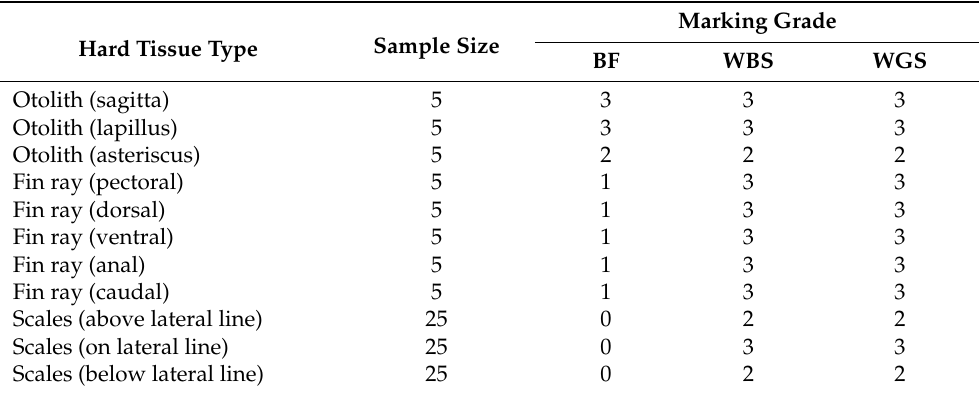
Table 2. Effect of a light source on the detection (mode marking grade) of alizarin complexone marking in hard tissues from five juvenile silver carps in the marked